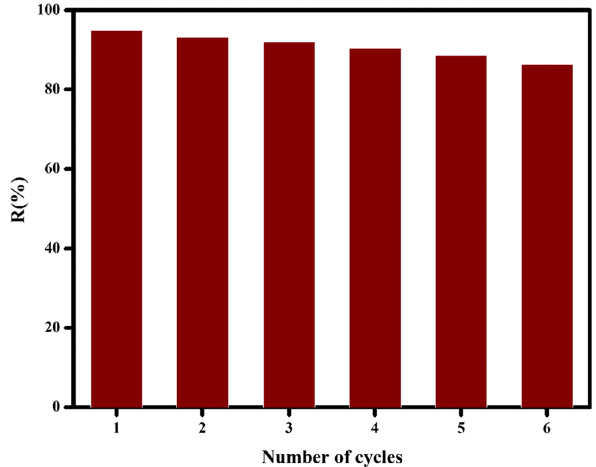
Fig. 11 Reusability performance of adsorption of MB